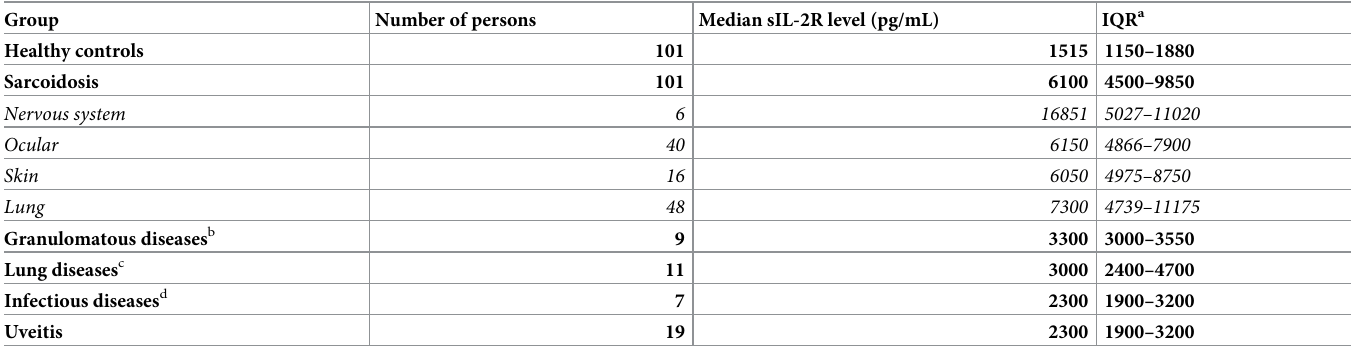
Table 4. Soluble interleukin 2 receptor